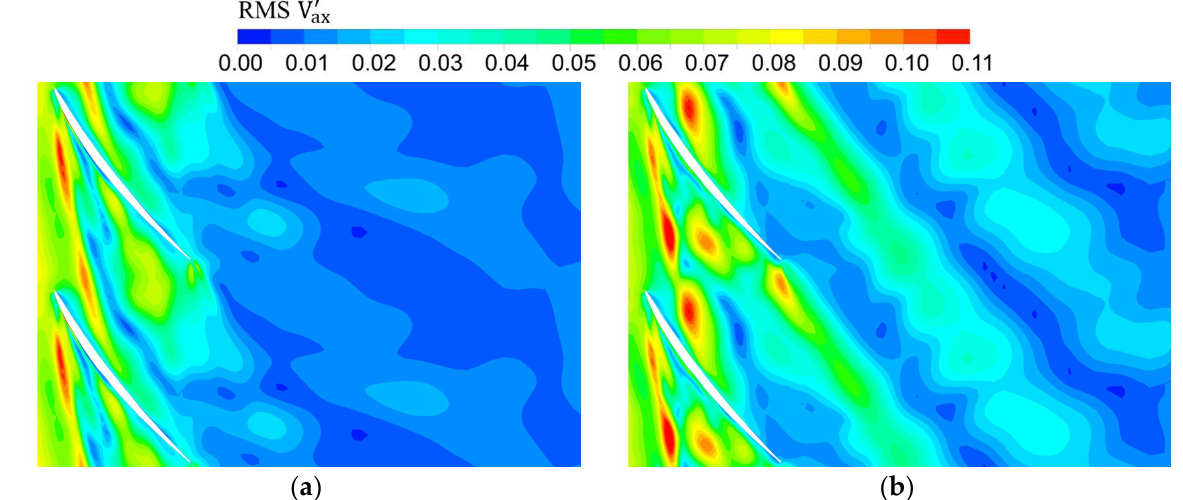
Figure 24. Distribution of root mean square of normalized axial velocity disturbance at 99% span. ( a ) Re = 1 × 10 5 ; ( b ) Re = 4 × 10 5 .